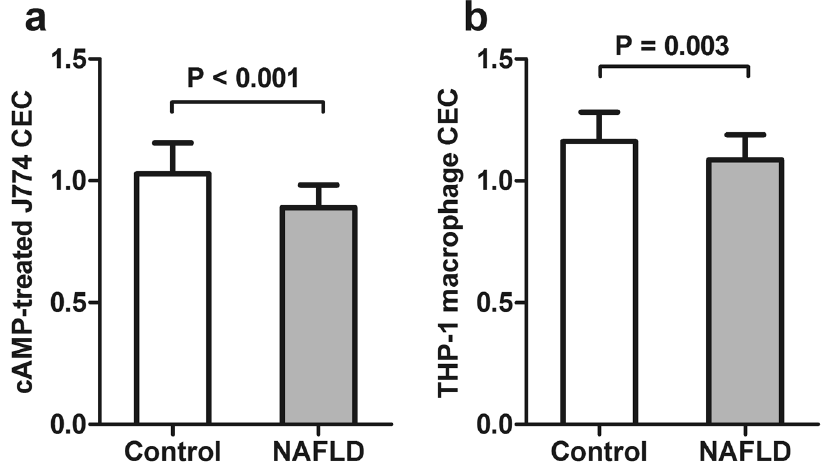
Figure 2. cAMP-treated J774 and THP-1 macrophage Cholesterol Efflux Capacity (CEC). ( a ) cAMP-treated J774 CEC showed significant decrease in NAFLD group compared with controls, before and after adjustment for age, BMI, HOMA-IR, TG, HDL-C (P < 0.001 and P = 0.001, respectively). ( b ) THP-1 macrophage CEC demonstrated significant decrease in NAFDL compared with controls (P = 0.003), but after adjustment for age, BMI, HOMA-IR, TG, HDL-C the significant difference was disappeared (P = 0.253). Data are shown in mean ± SD.